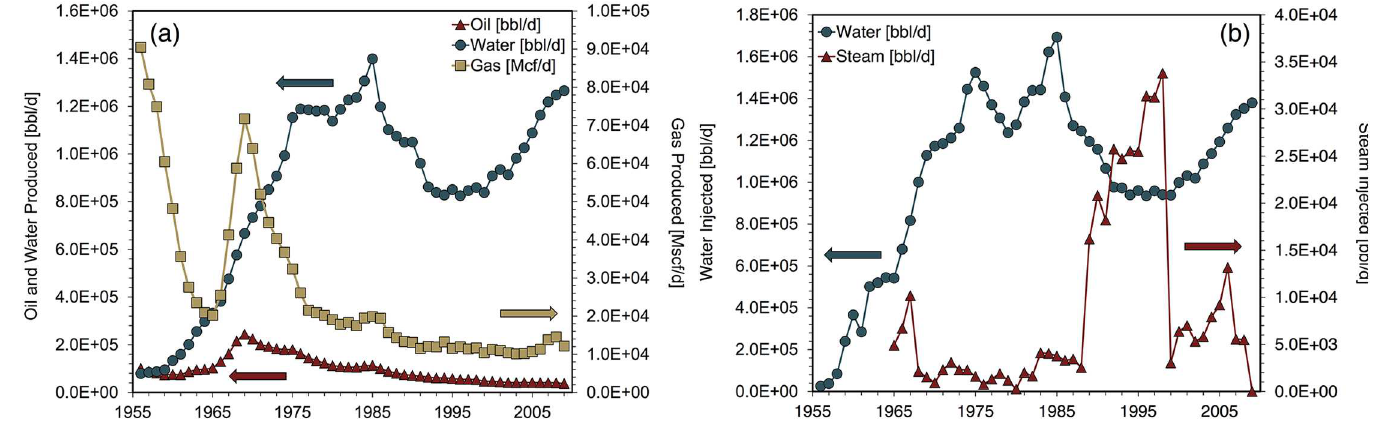
Fig 6. Wilmington input data for fluid production and injection. (a) Fluid production, (b) fluid injectionSource: